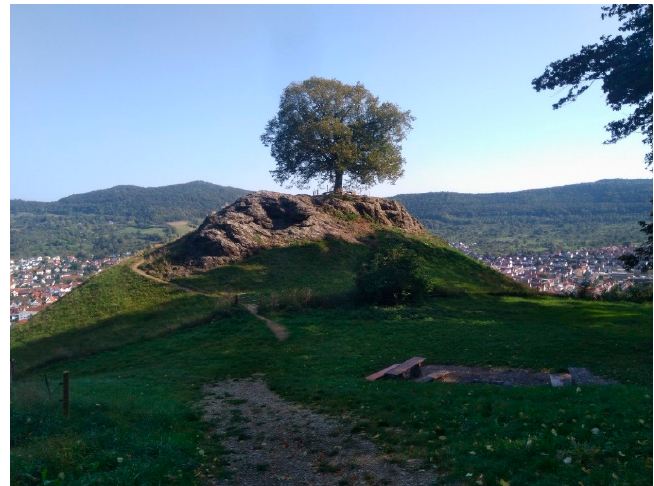
Figure 12. Volcanic vent Calver Bühl (Author 2020).